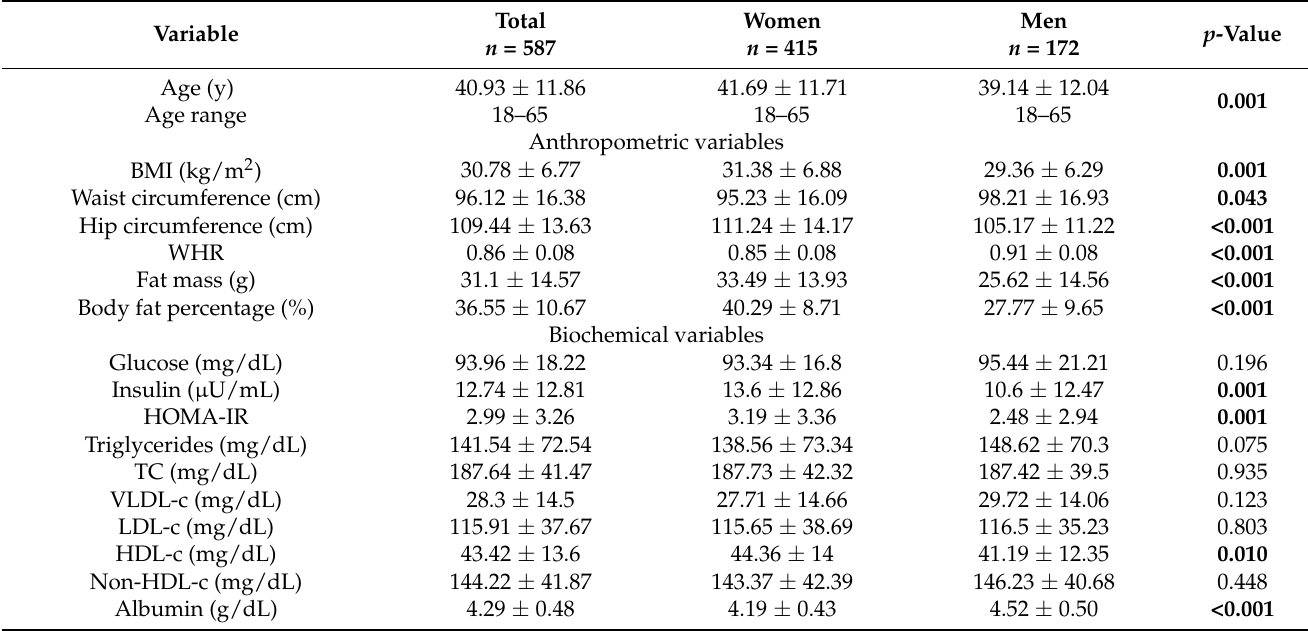
Table 1. Characteristics of the study population.